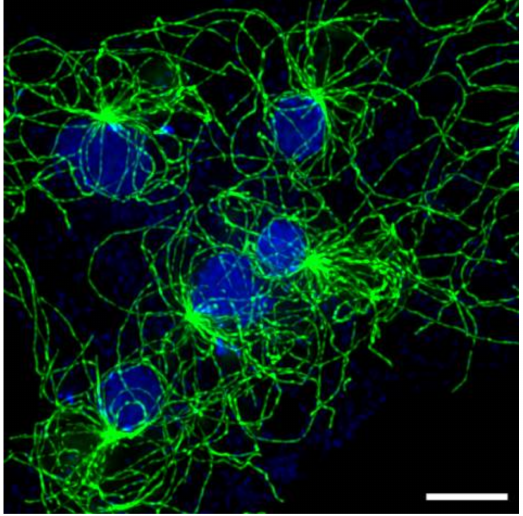
Figure 3. Multinucleated cell. Selected area of an exceptionally large, flattened cell containing multiple nuclei—five are visible here. Each nucleus is bound to a centrosome; each with a distinguishable MT array. Scale bar = 5 µ